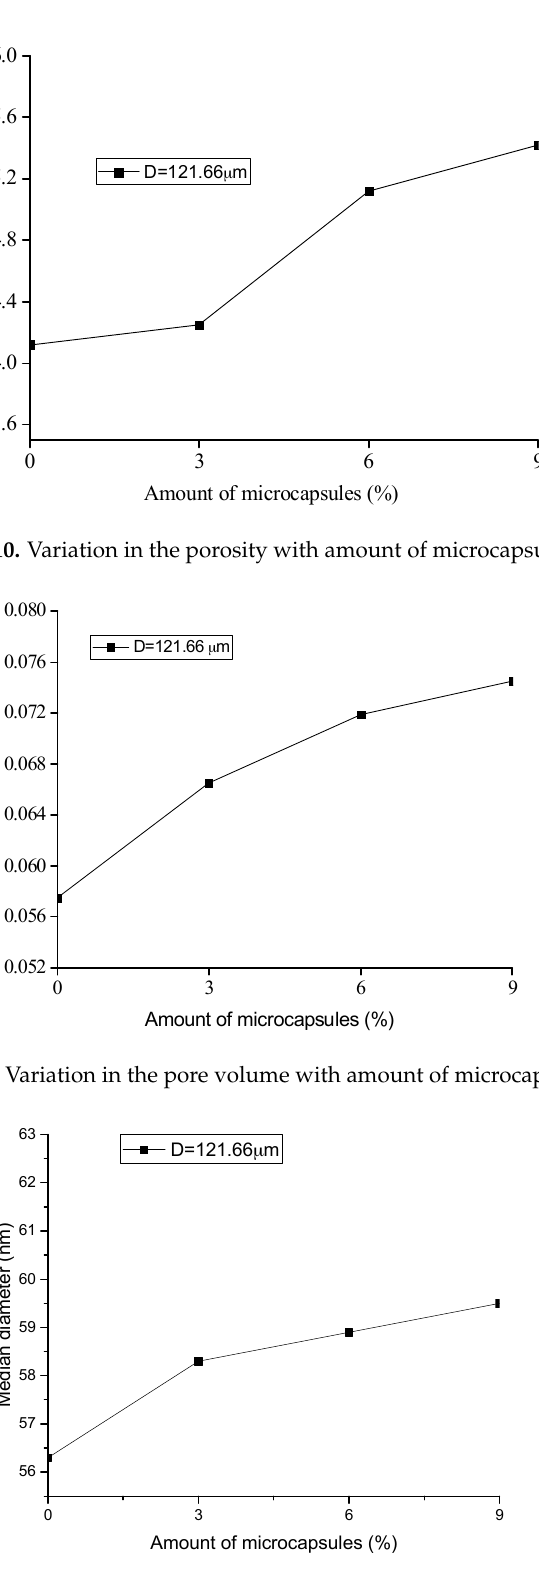
Figure 12. Variation in the median pore diameter microcapsules.